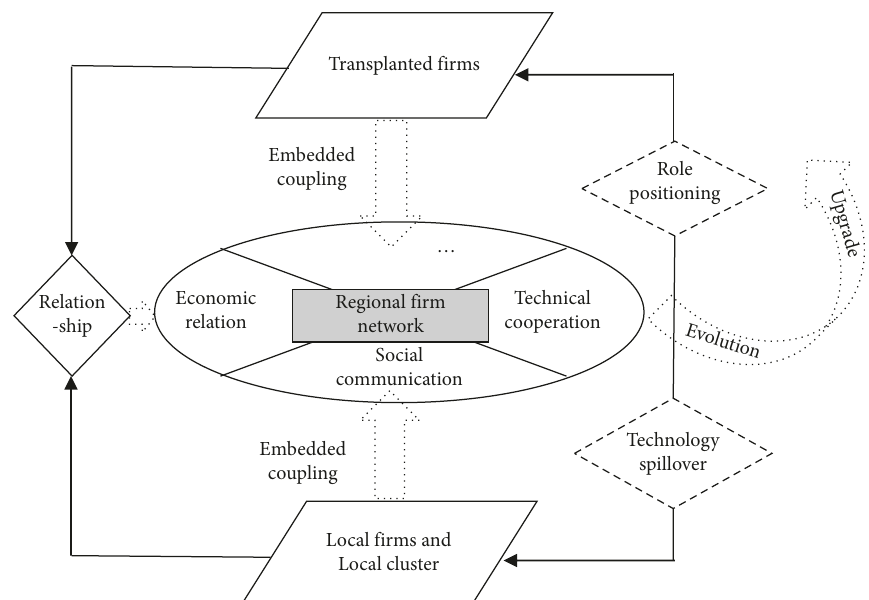
Figure 1: Theoretical framework of this